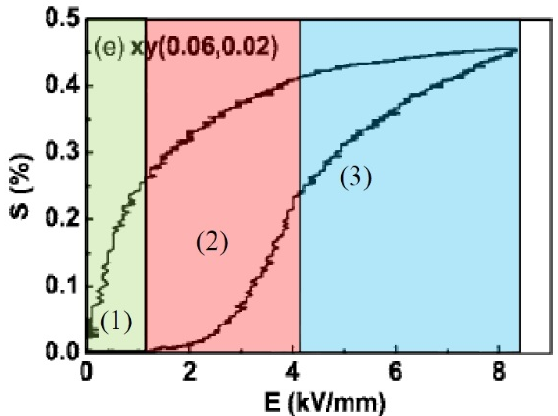
Figure 7. The positive part of the strain versus applied electric field loops for 92 BNT-6BT-2KNN. The regions indicated in the diagram are responsible for the peculiar electromechanical behavior and are related to a particular structure of the material: (1) low-strain region, weak ferroelectric; (2) electrostrictive region, relaxor ferrielectric; and (3) ferroelectric linear region (reprinted with permission from reference [18]. Copyright from AIP Publishing LLC 2008).